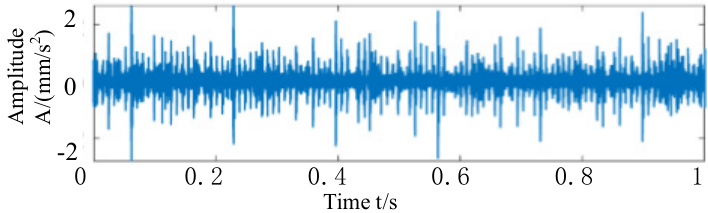
Figure 20. Time-domain waveform of the transient shock characteristics.